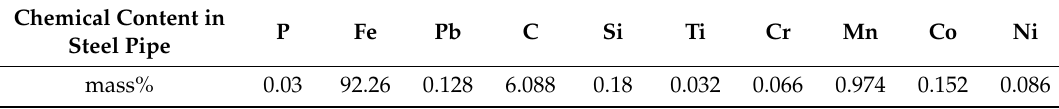
Table 2. Chemical composition of the steel pipeline in